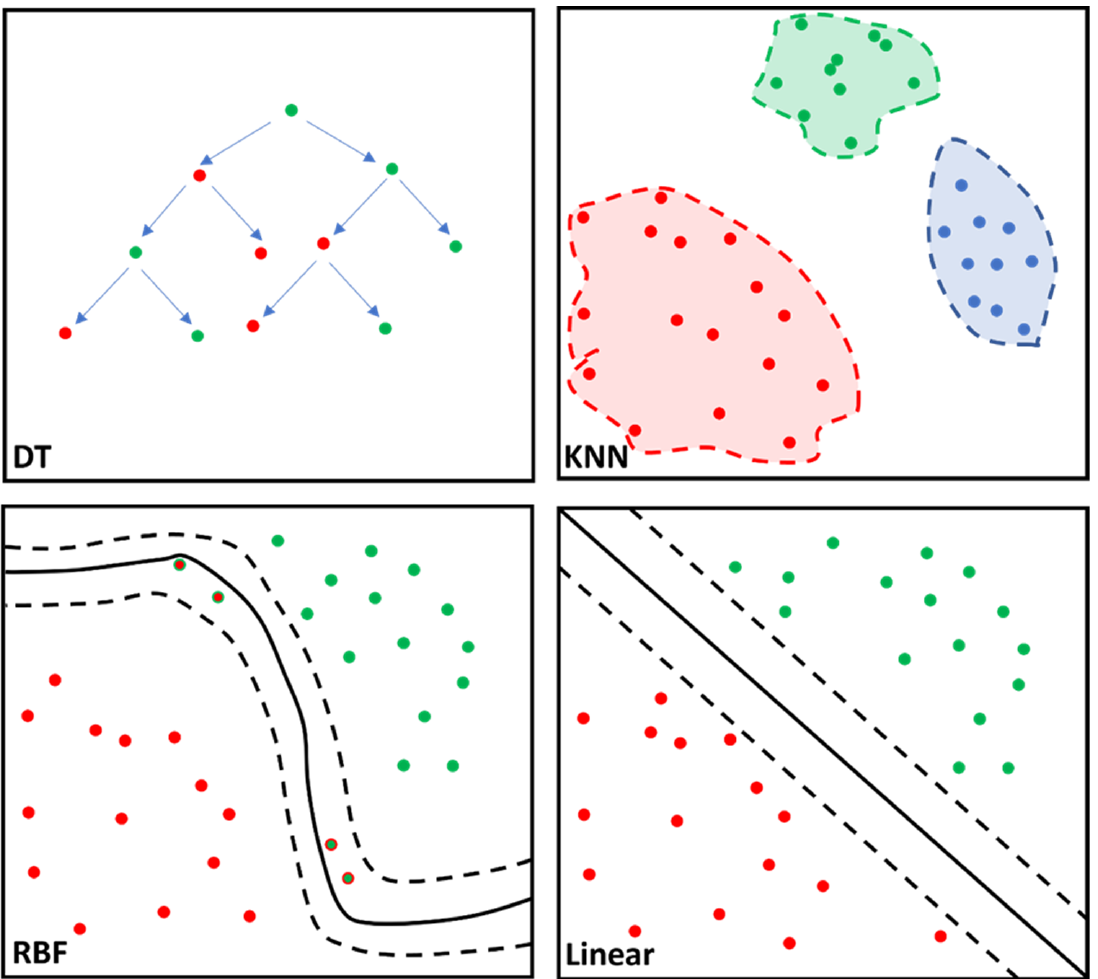
Figure 2. Simplified illustration of the classifier algorithm function for the decision tree (DT), k- nearest neighbor (KNN), support vector machine (SVM), radial basis function (RBF) kernel and SVM linear are portrayed. DT is characterized by the nodes (dots) representing variables and the branches (arrows) representing decisions. KNN calculates data proximity (Euclidian distance) by assuming similar variables remain at a shorter distance from one another. RBF computes similarity between two data points ranging from 0 (similar) to 1 (dissimilar) enabling complex separation between data points. SVM linear separates the data points based on the linear dividing “hyperplane”, albeit with less flexibility than SVM RBF kernel. Different colored dots represent different cohorts; solid line corresponds to best separation of cohorts; dashed lines represent confidence intervals.